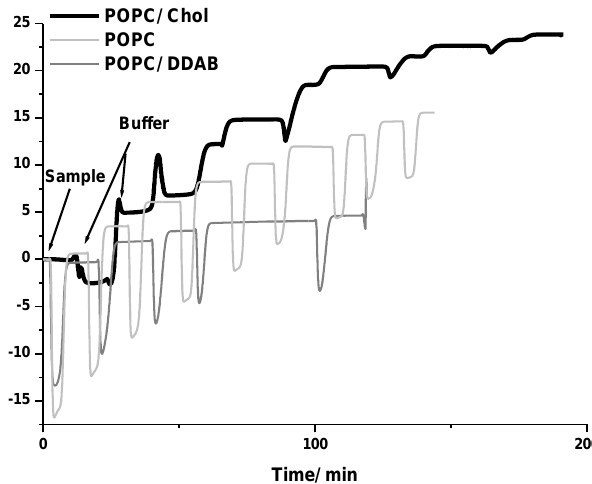
Figure 2. Average kinetic curves variation of reflectivity on the biochip after injections of gold NPs on POPC, POPC/DDAB and POPC/Chol membranes.